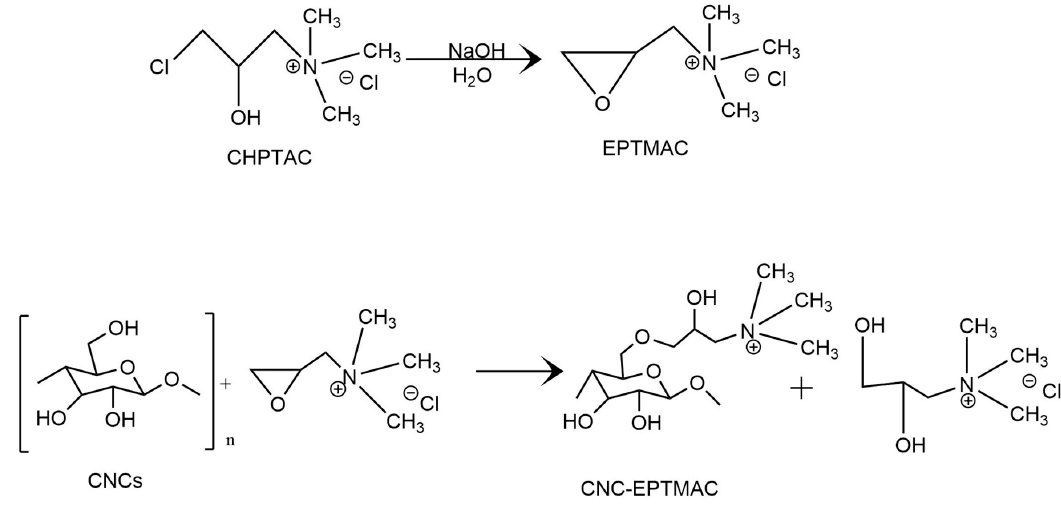
Figure 1. CNC-EPTMAC etherification reaction.